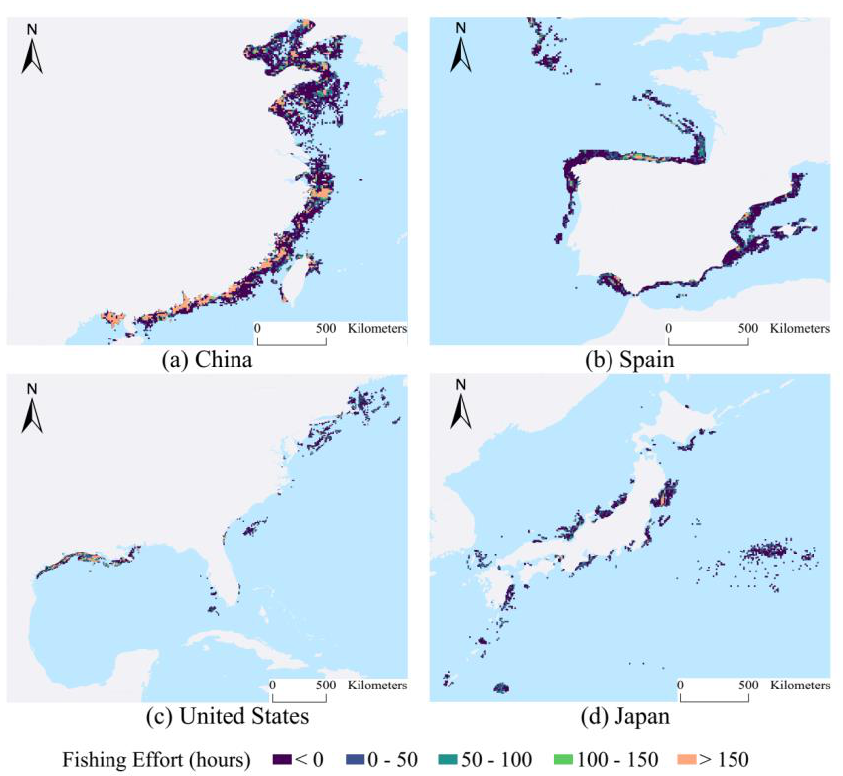
Figure 12. Lockdown and non-lockdown countries’ fishing effort (hours) spatial distribution from 341